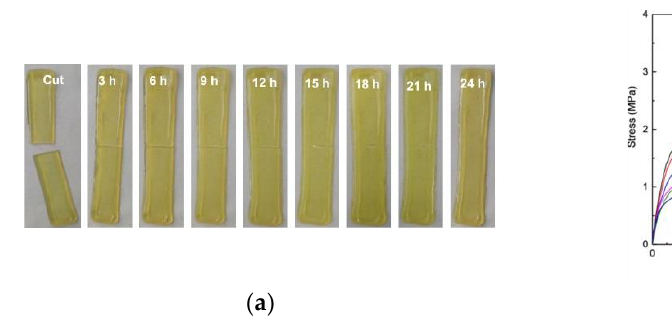
Figure 10. ( a ) DDSQ[P(BA- co -UPyA40)] 2 samples during self-healing tests at 40 °C; ( b ) Stress−stain curves for the evaluation of the self-healing properties of DDSQ[P(BA- co -UPyA10)] 2 and DDSQ[P(BA- co -UPyA40)] 2 at 40 °C. Reprinted with permission from ACS Appl. Polym. Mater. 2020 , 2 , 3327 – 3338. [72] Copyright (2020) American Chemical Society.